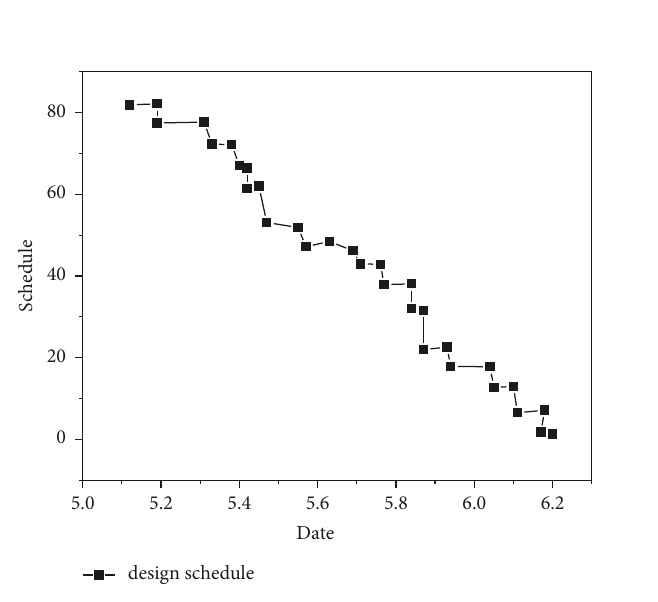
Figure 3: Table 5: Data statistics.